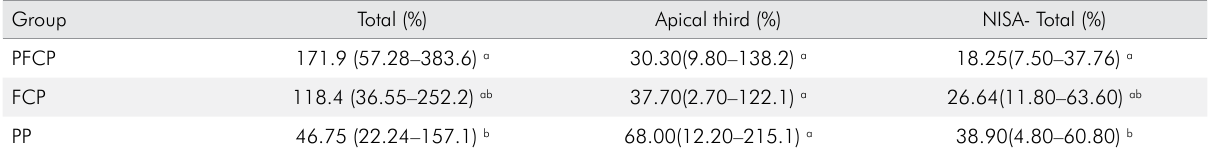
Table 1. Percentage values of increase in volume in the total portion and at the apical third of the root canal and in the non- instrumented surface area in the total portion of the root canal (median,